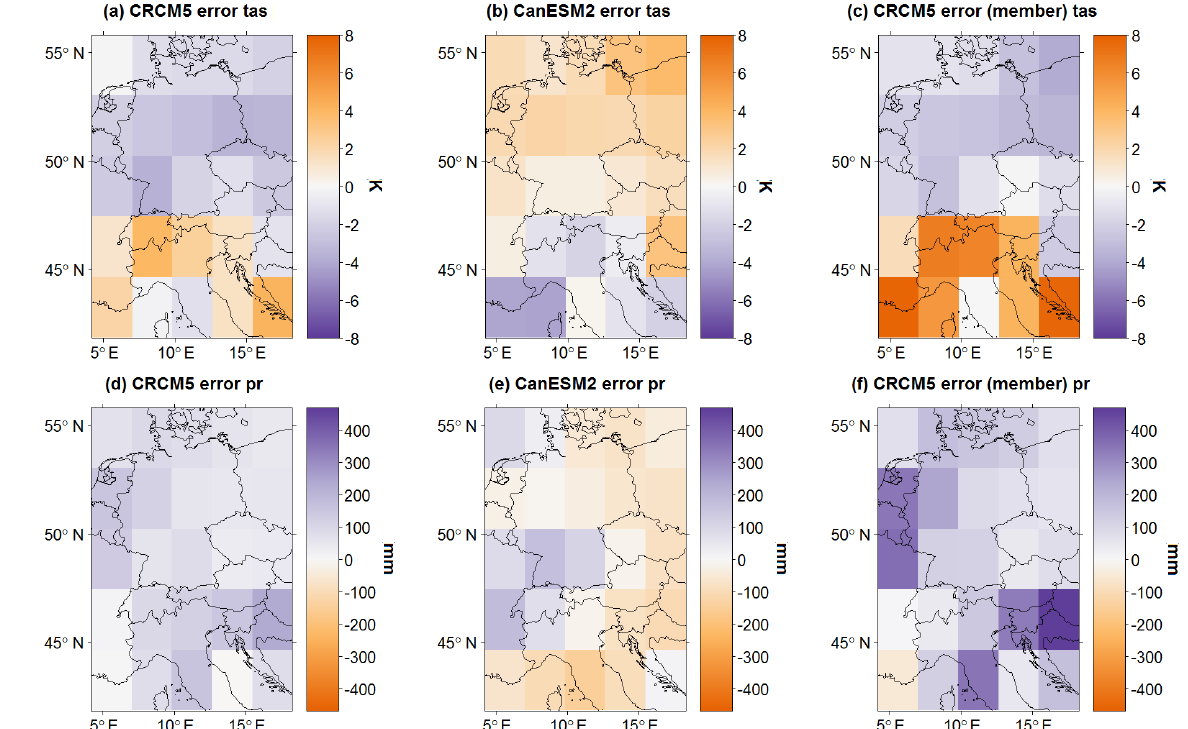
Figure A1. Model deviation for the 1981–2010 winter mean nSAT mean (a–c) and winter mean PR sum (d–f) in GCM resolution (2.8 ◦ ). (a, d) Error of CRCM5 under ERA-I boundary conditions (difference between CRCM5/ERA-I and ERA-I). (b, e) Error of CanESM2-LE towards ERA-I data (ensemble mean of differences between CanESM2-LE members and ERA-I). (c, f) CRCM5 error under CanESM2-LE boundary conditions (ensemble mean of differences between CRCM5 members and corresponding CanESM2